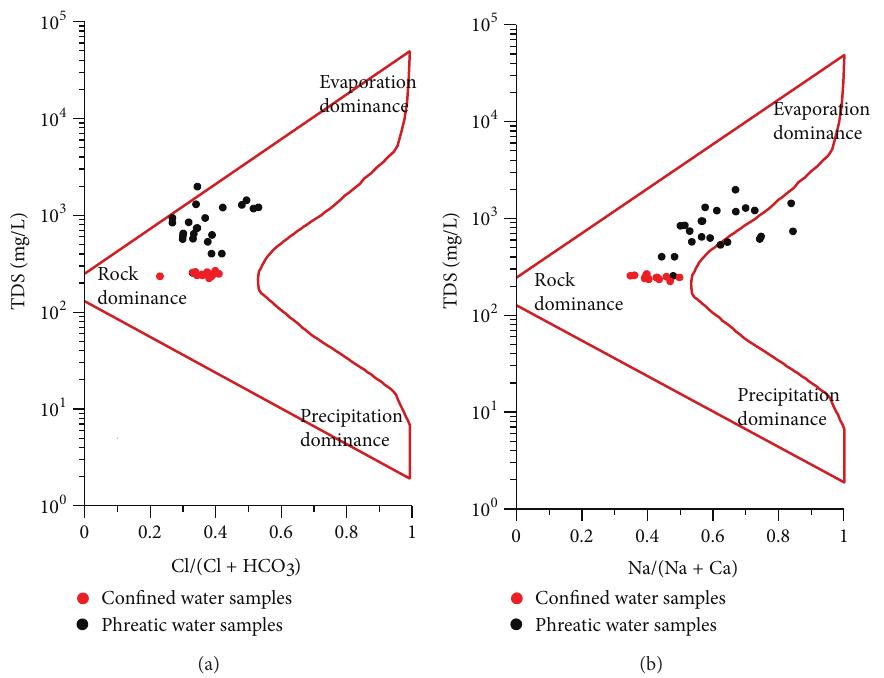
Figure 5: Gibbs diagram showing TDS versus (a) Cl/(Cl + HCO 3 ) and (b) Na/(Na + Ca).